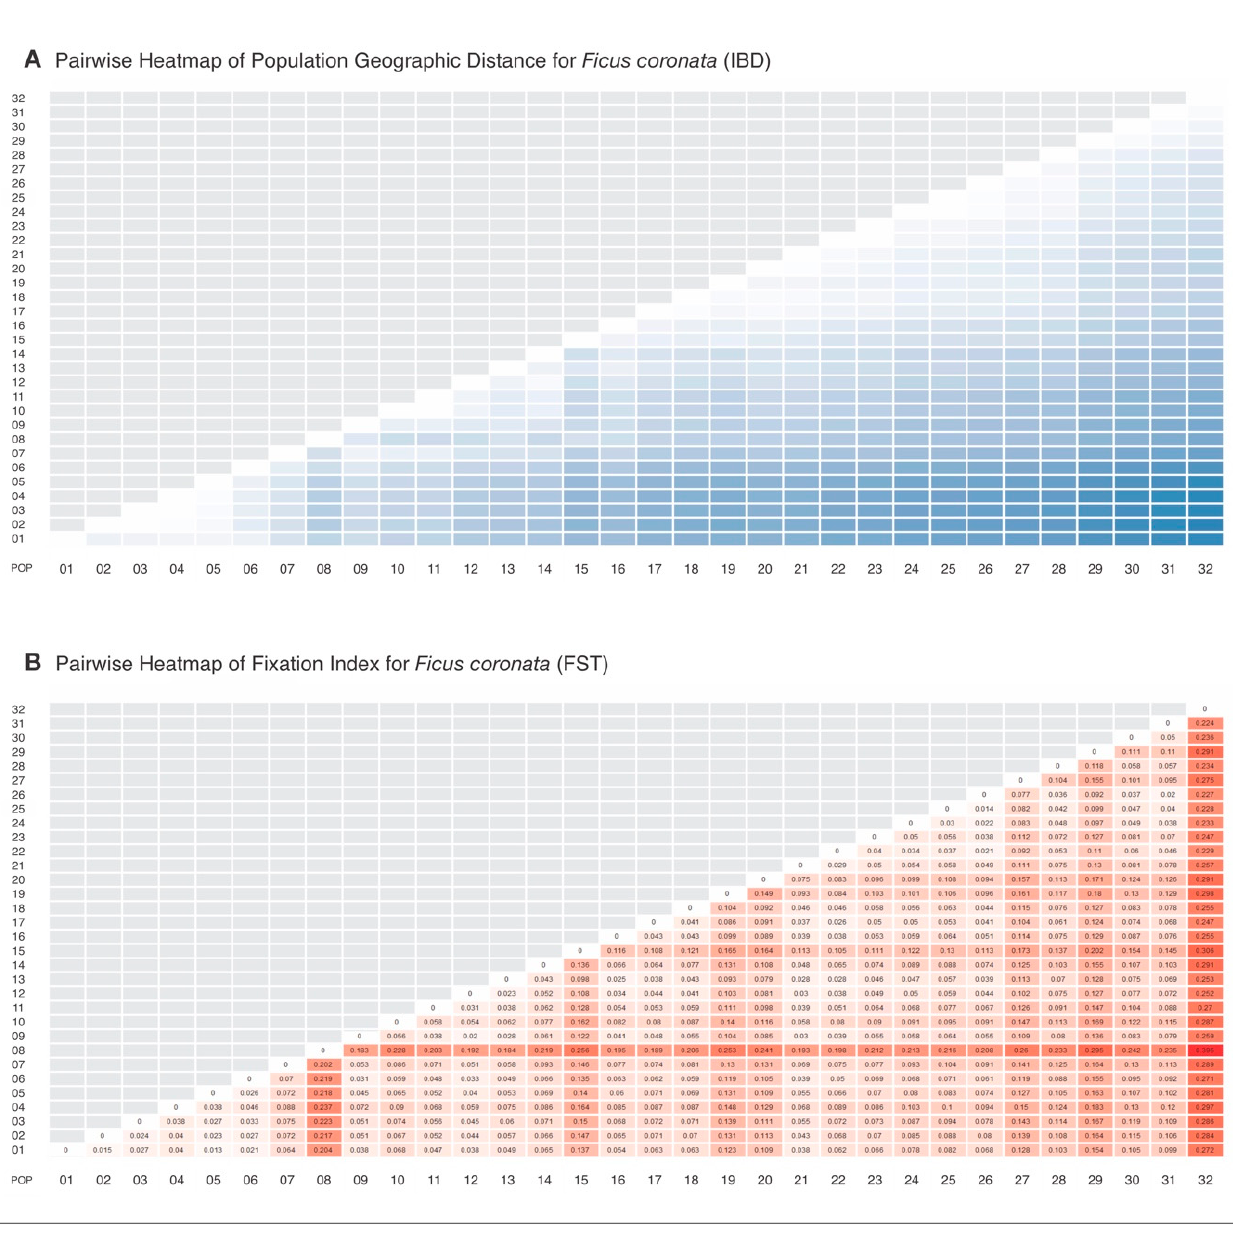
Figure 1. ( A ) Heatmap showing pairwise comparison of population geographic distance or genetic isolation by distance (IBD). Scale from white to blue; no genetic difference to high genetic difference. ( B ) Heatmap of pairwise comparison of the fixation index ( F ST ). Scale from white to red; no difference or total gene flow with paired population to high differentiation or no gene flow with paired